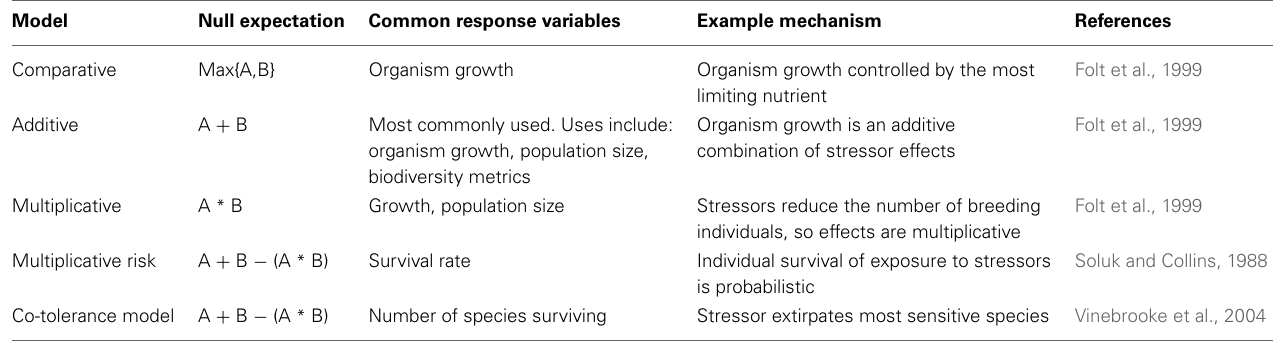
Table 1 | Common models for determining interaction